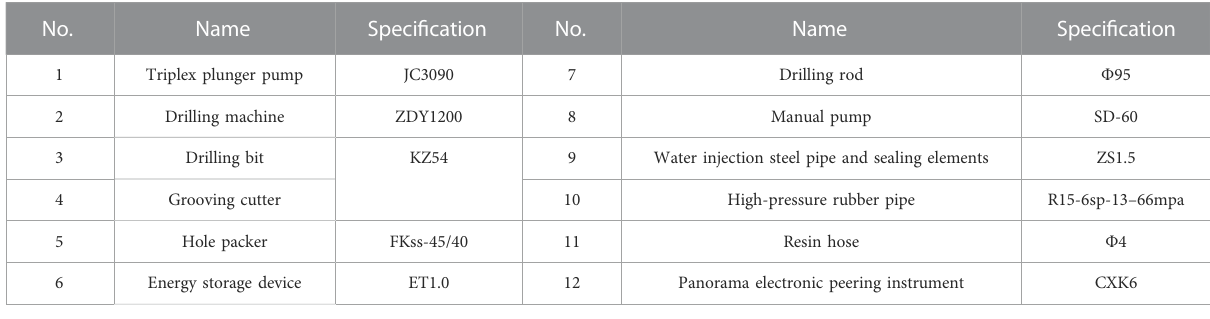
TABLE 4 Main construction equipment.